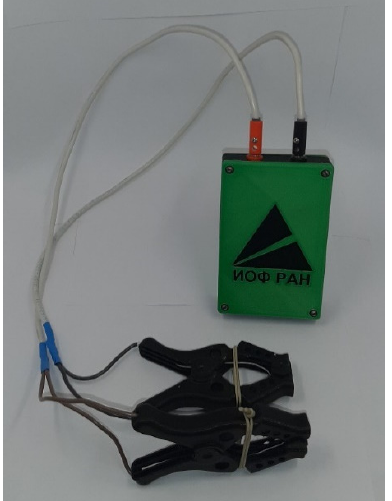
Figure 2. A device for determining the complex resistance (impedance).